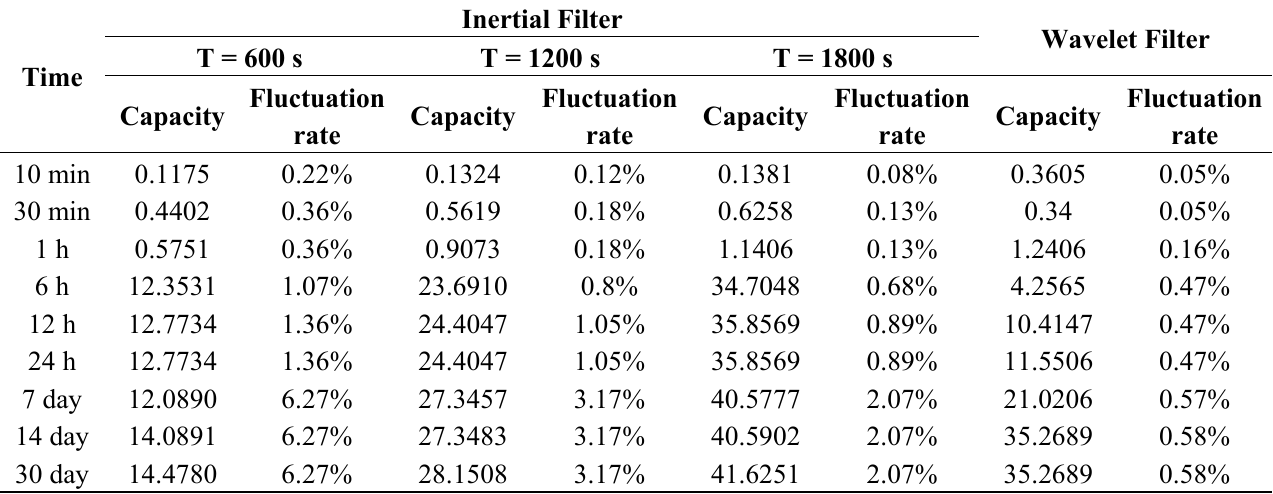
Table 1. The battery capacity allocations used for a wind farm in April (MWh).